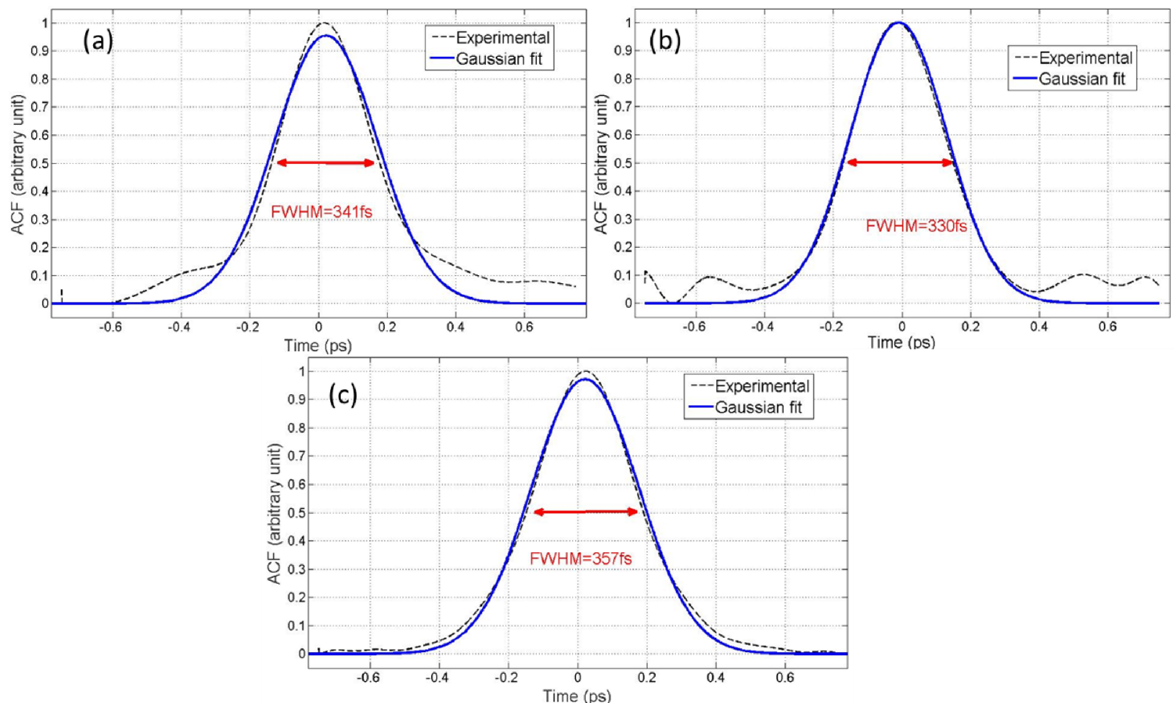
Figure 4. Autocorrelative characterization and corresponding Gaussian fit of the three sources: ( a ) Ti:Sa; ( b ) OPO; ( c ) SHG.